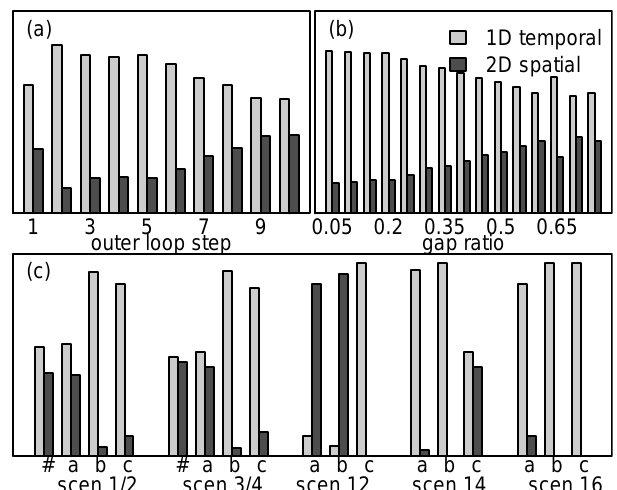
Fig. 5. Dimensions chosen (i.e. temporal 1-D vs. spatial 2-D) for all test datasets and all steps plotted for (a) the dimension choosing outer loop steps, (b) the ratio of missing values, and (c) the different gap and data type scenarios. # denotes the gap free egg-boxes of scenarios 1 and